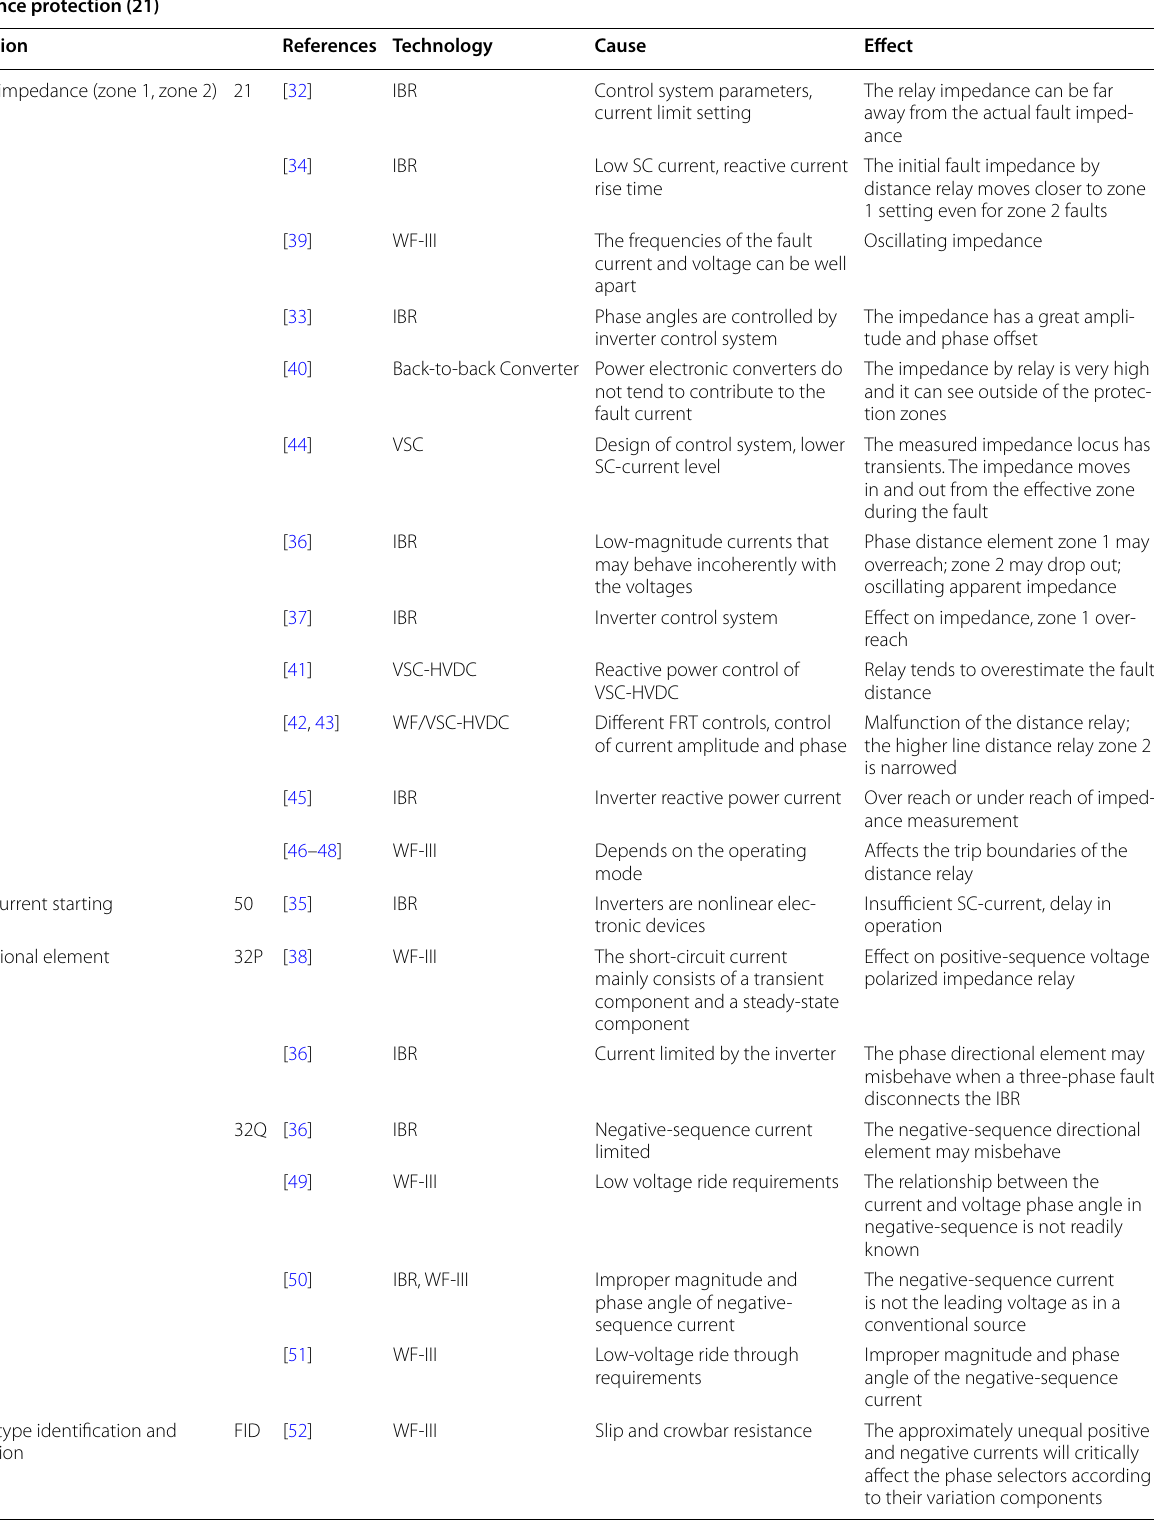
Table 6 Causes and effects on distance protection due to IBRs Distance protection